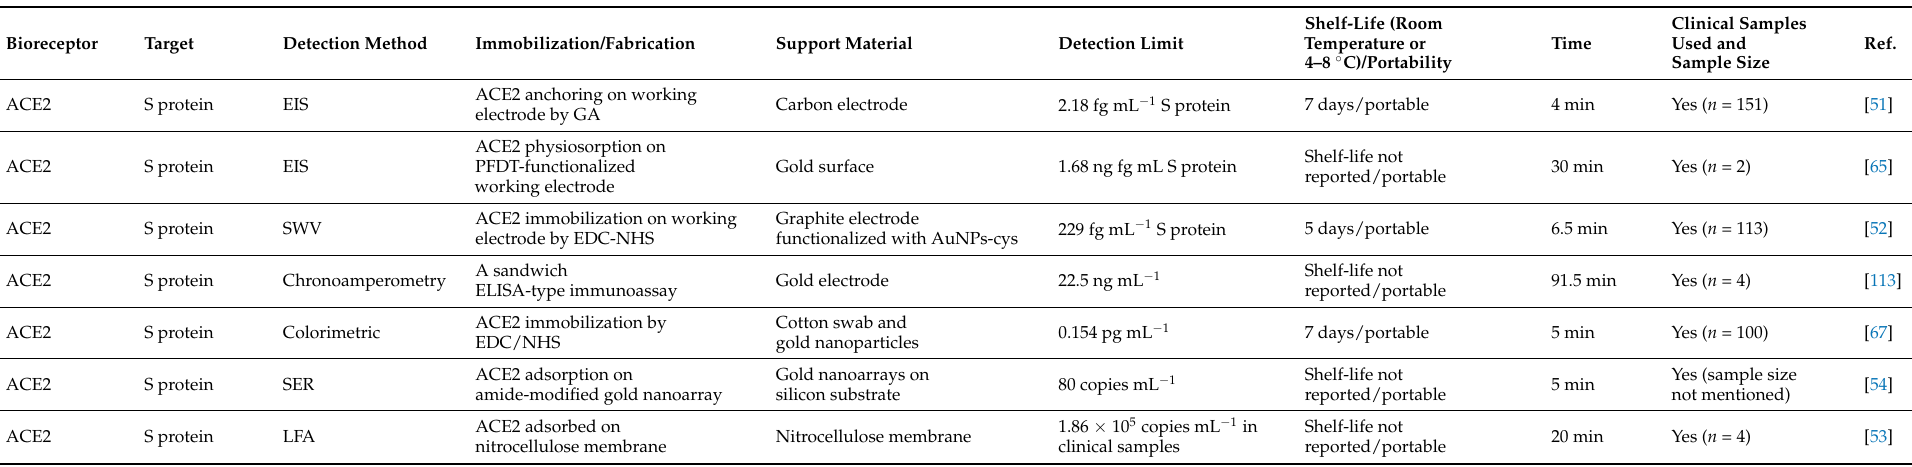
Table 1. Summary of ACE2-based SARS-CoV-2 biosensors.